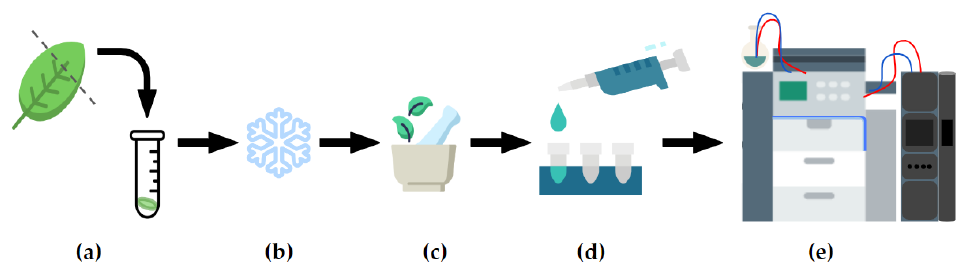
Figure 2. Conceptual diagram of an untargeted metabolomics workflow, from leaf to mass spectrometry analysis. After sample harvest ( a ), metabolic reactions in a sample tissue must be